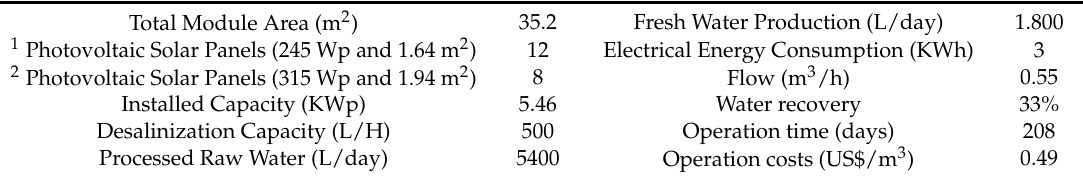
Table 4. PSPP/BWRO System installed at the Maria DA PAZ